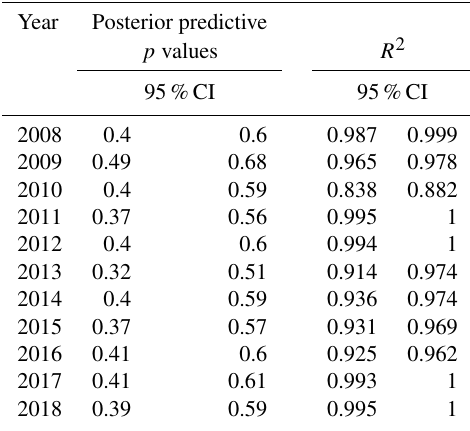
Table 1. Bayesian model assessment via p value (posterior predic- tive p values of 0.5 are indicative of a good fit and 95%CI (credible interval) of our yearly results, each containing 0.5), and R 2 (each year > 0.8) showed the model-generated posterior samples similar in structure to the